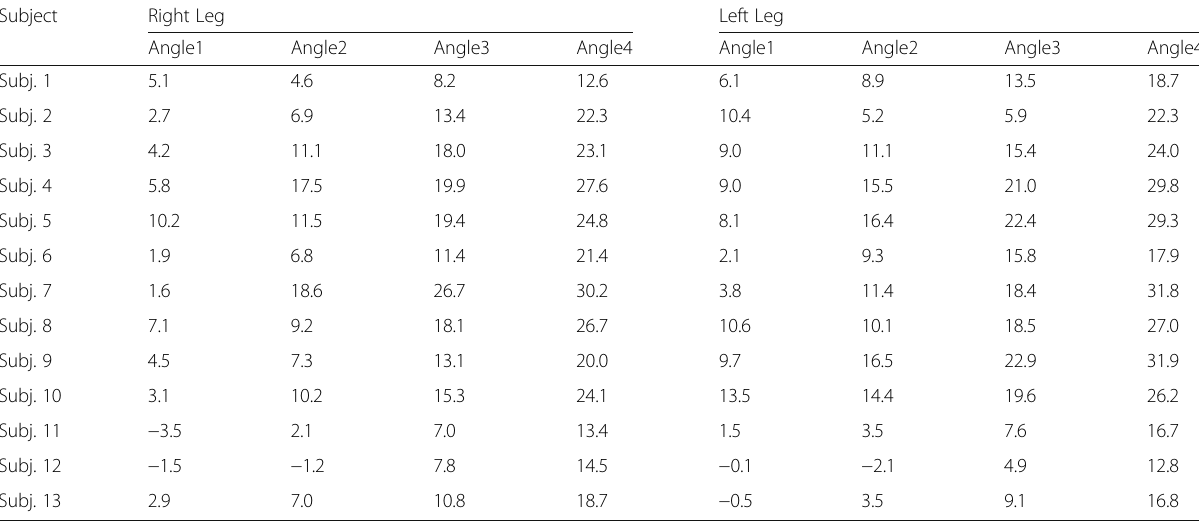
Table 2 The measured knee angles. The knees were scanned in four different angles of flexion-extension. The angle was measured from the MR images as the angle between the axes of the distal femur and proximal tibia in the sagittal